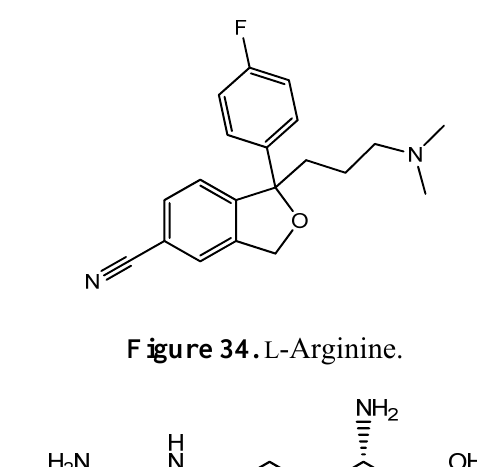
Figure 34. L -Arginine.